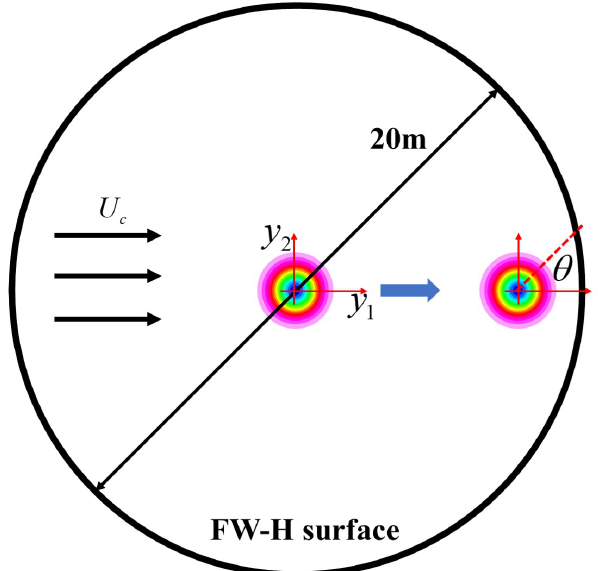
Figure 4. Schematic of the incompressible convecting vortex.